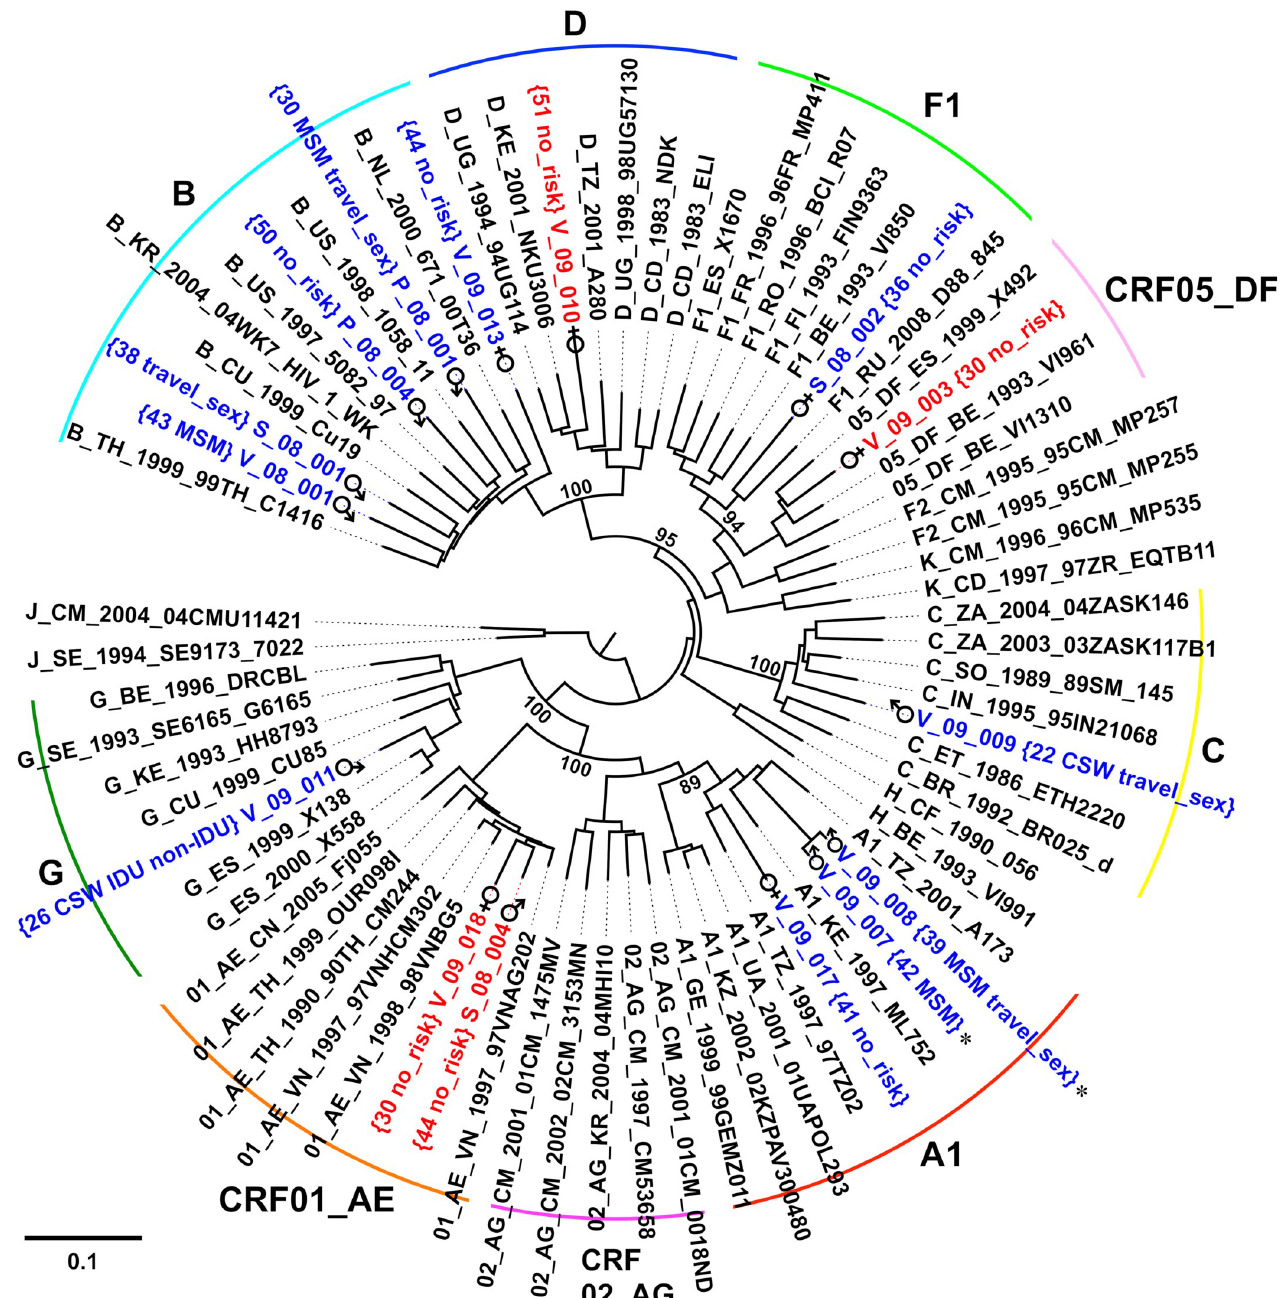
Fig 4. Phylogenetic tree of full-length HIV-1 sequences from Bulgaria. Neighbor-joining tree of full-length sequences denoted with group subtypes, participant age at enrollment, gender, and self-identified risk factors. Study participant strains from pure subtypes are shown in blue and recombinant strains are shown in red. The closely related pair of strains with an env genetic distance of 2.5% are marked with � . Bootstrap values at relevant nodes are shown. The scale bar indicates a genetic distance of 10%.